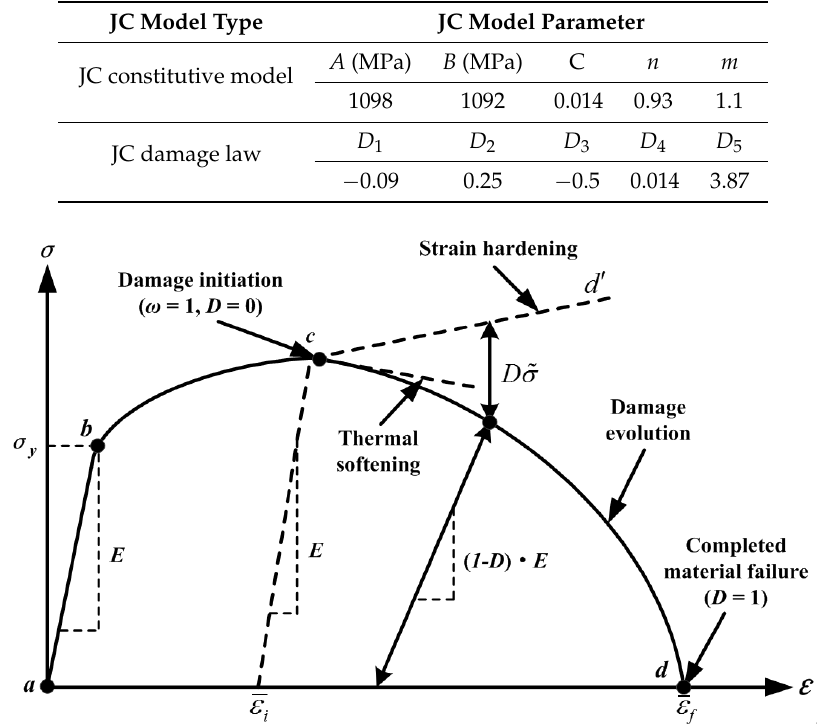
Figure 2. Typical uniaxial strain–stress ( ε – σ ) responses of ductile material failure process [23]. (Note: σ y is the yield stress, r σ is the effective (or undamaged) flow stress, ε i implies the equivalent plastic strain at damage initiation and ε f indicates the equivalent plastic strain at